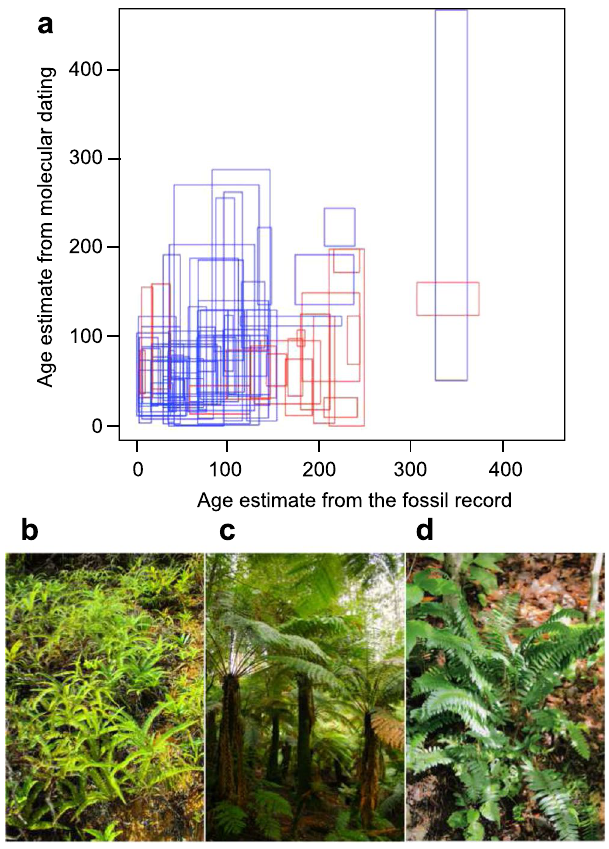
Figure 3. Characterisation of the studied fern genera. ( a ), Estimated ages of fern genera present in both molecular and fossil data sets ( n = 76). Molecular age interval represents 95% HPD combining the stem and crown group nodes. Genera with congruent age estimates between the two methods are shown in blue and non-overlapping estimates in red. ( b ) Representative taxa from the analyses that include both living and extinct relatives: Gleicheniales: Dicranopteris flexuosa . ( c ) Cyatheales: Dicksonia antarctica . ( d ) Polypodiales: Polystichum acrostichoides